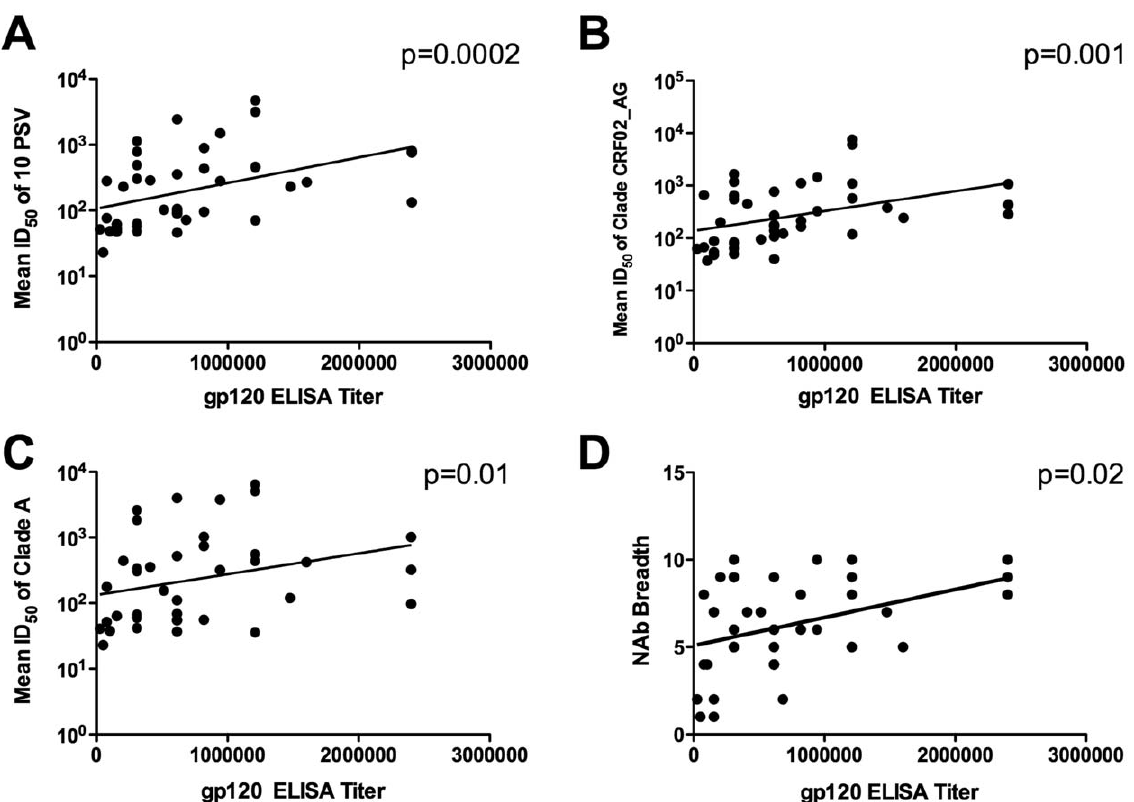
Figure 6. Binding antibodies against HIV-1 gp120 correlate with mean NAb Titer and breadth of neutralization. Subtype A gp120 binding antibody titers correlate with the mean NAb titers against all 10 pseudoviruses (A) and the mean ID 50 s of subtype CRF02_AG (B) and subtype A (C) pseudoviruses. A significant correlation was also seen between the gp120 binding antibody titers and neutralization breadth, as measured by the number of viruses neutralized (D).